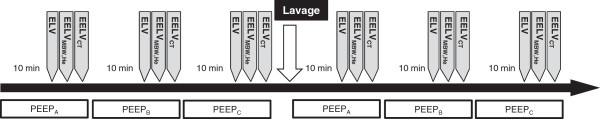
Scheme of the experimental protocol.